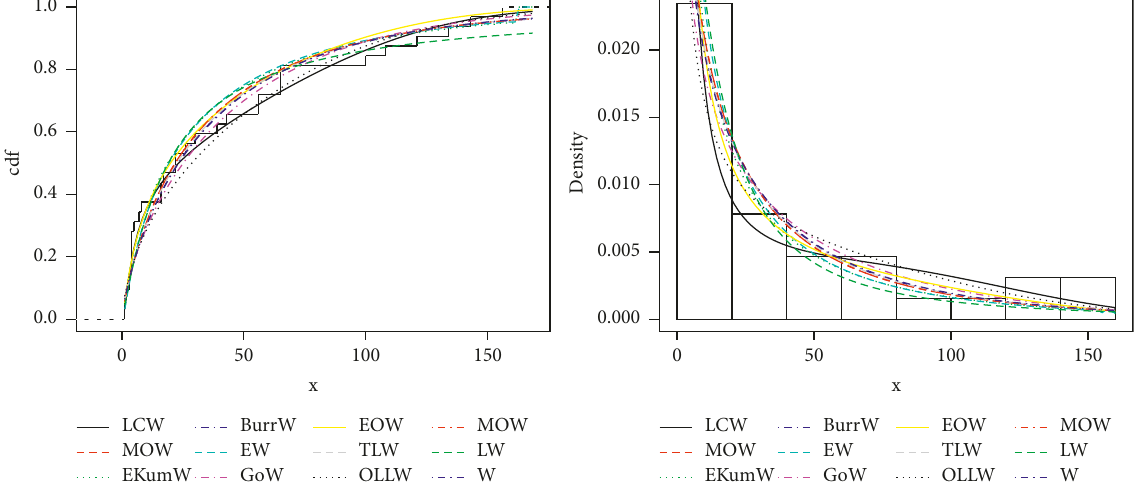
Figure 9: The comparative cdf and pdf of LCW and other models using survival time data.